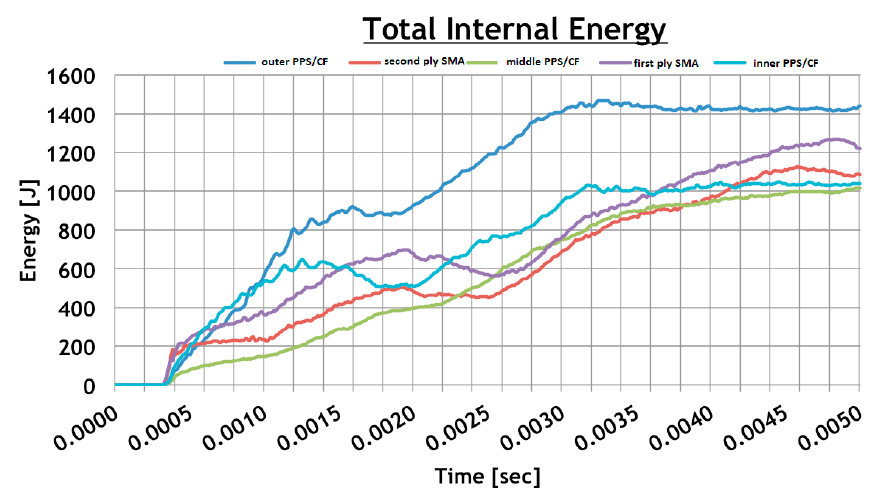
Figure 13. Total internal energy for each layer.